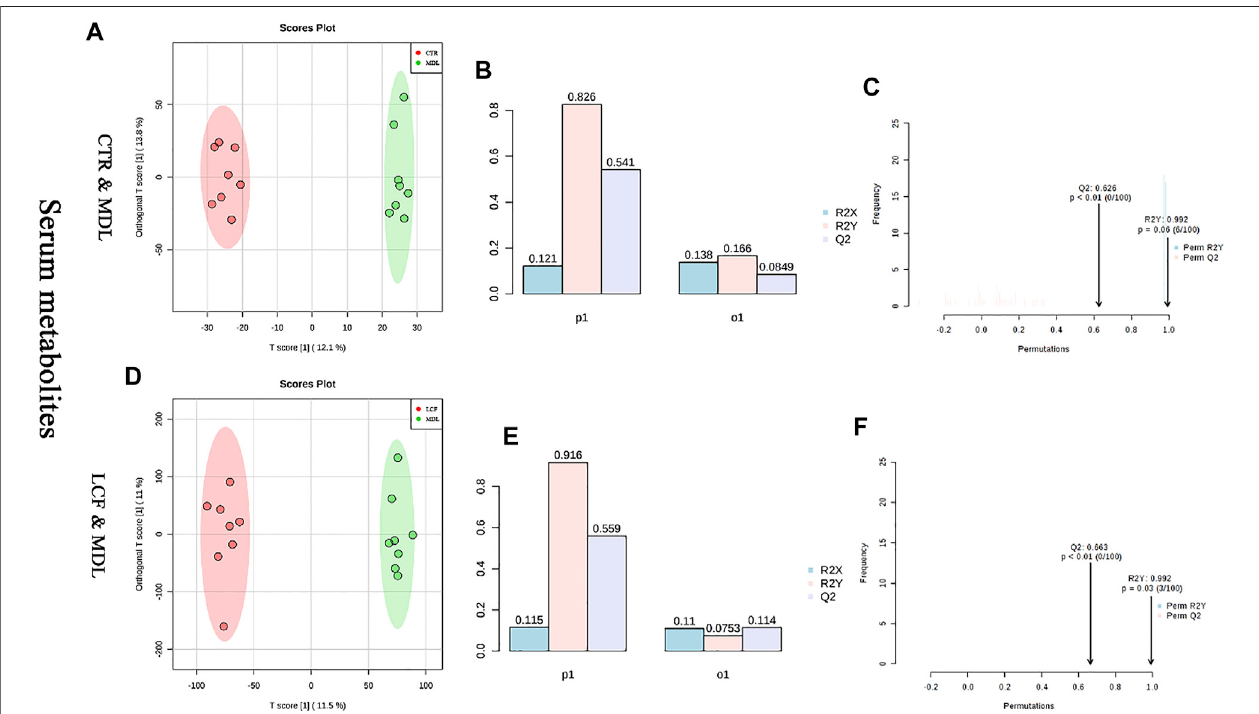
FIGURE 7 | Analysis of OPLS-DA model between serum metabolites; (A) CTR vs. MDL OPLS-DA score map, (D) : LCF vs. MDL OPLS-DA score map, (B/E) : OPLS-DA parameter test, (C/F) : OPLS-DA alignment test.